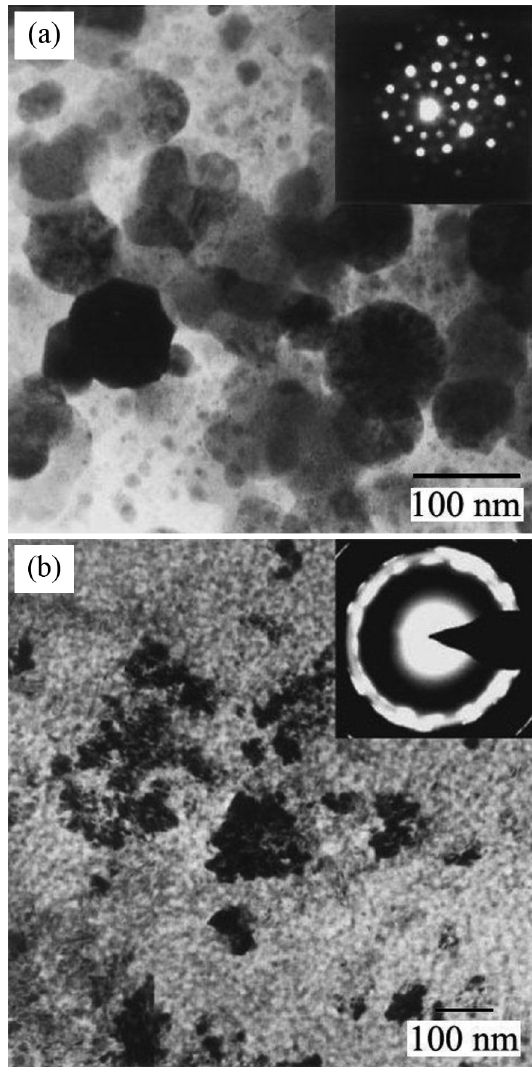
Figure 10. Bright field TEM images of Al (a) 20 and (b) 50 m/s. The inset of (a) is the microdiffraction pattern obtained from an i-phase particle and that of (b) is the selected area Zr Ni Mm 95 1 1 3 diffraction pattern from the alloy melt-spun at 50 m/s [38]